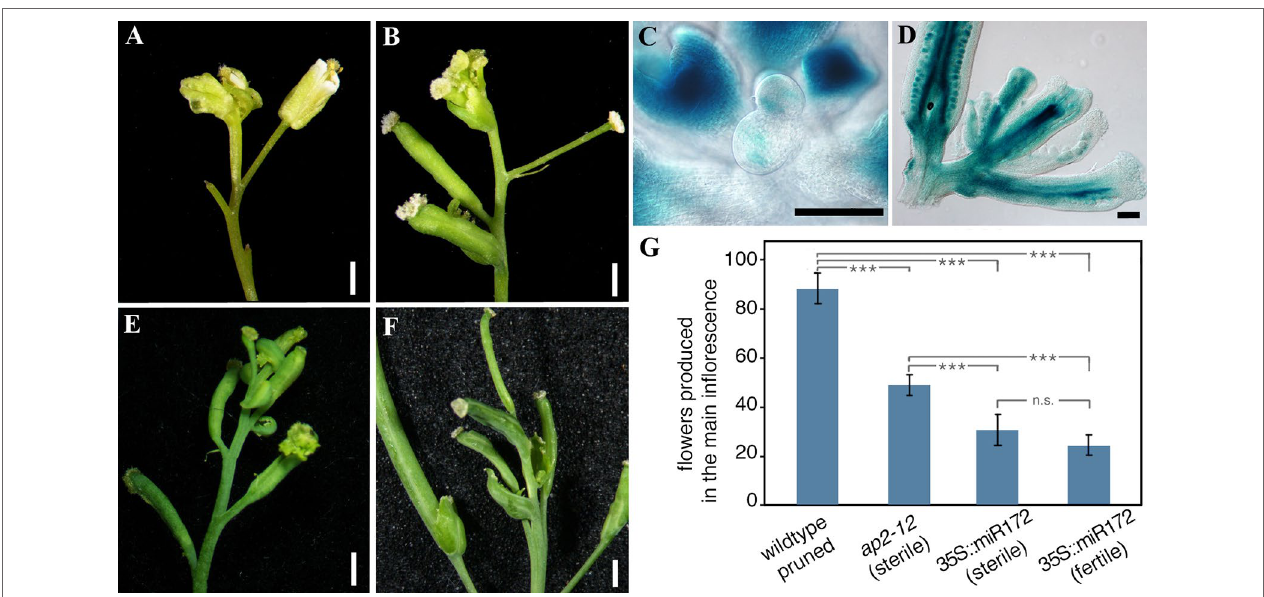
FIgURe 4 | AP2 prevents terminal flower formation. (a) Pruned/wild type inflorescence 6 weeks after the floral transition. The inflorescence meristem differentiates into a terminal carpeloid structure. (B) The sterile ap2–12 mutant also ends flowering with the formation of an early terminal flower 3–4 weeks after floral transition. (c) The terminal floral structure observed in the ap2–12 mutant is preceded by ectopic AG expression in the SAM 3 weeks after floral transition. (D) AG::GUS activity is strongly detected in the terminal structure of ap2–12 inflorescences 4 weeks after floral transition. (e) The sterile 35S::miR172 plants also end the flowering phase with the formation of the terminal floral structure around 2 weeks after bolting. (F) A similar terminal flower formation is also observed in the 35S::miR172 that occasionally developed fertile pods, suggesting that the formation of the terminal floral structure depends on the activity level of AP2-like genes. (g) Flower production before terminal flower formation in the main inflorescence of wild type pruned plants, ap2–12 mutants (sterile), 35S::miR172 sterile lines, and 35S::miR172 fertile lines. The number of flowers produced in the lines where AP2 and AP2-like activity is reduced is much lower than in wild type plants where seed production was avoided. Error bars represent s.d. A pair-wise Student’s t-test, correcting with Holm method for multiple testing and linked to a post-hoc analysis, was performed to indicate genotypes with significant differences. *** indicate a significant difference (P < 0.001), n.s., not significative. N≥ 15. Black bars in (c , D) represent 100 μm. White bars in (a , B , e , F) represent 1